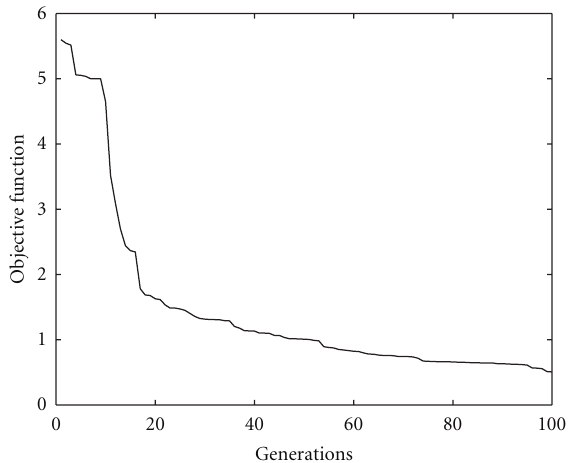
Figure 11: Convergence graph in the ACO method of the G 3 ( s ) plant.